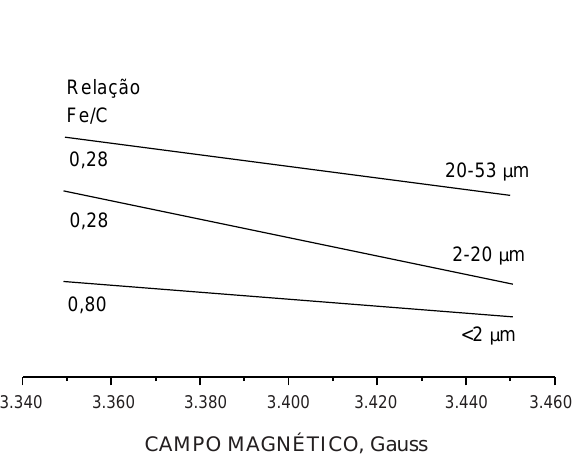
) extraído do Podzólico 2